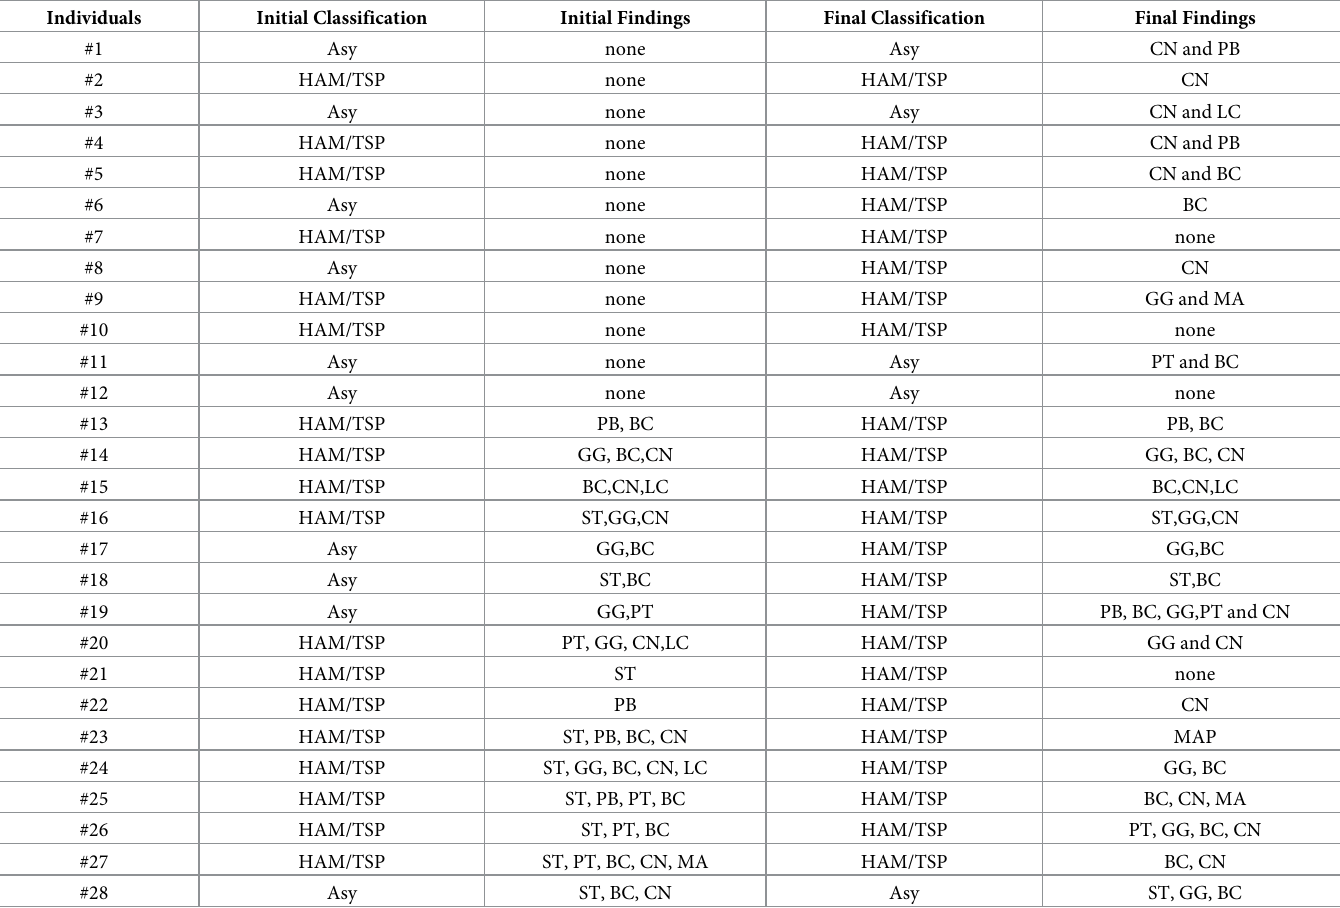
Table 2. Chest CT findings at assessment and follow-up